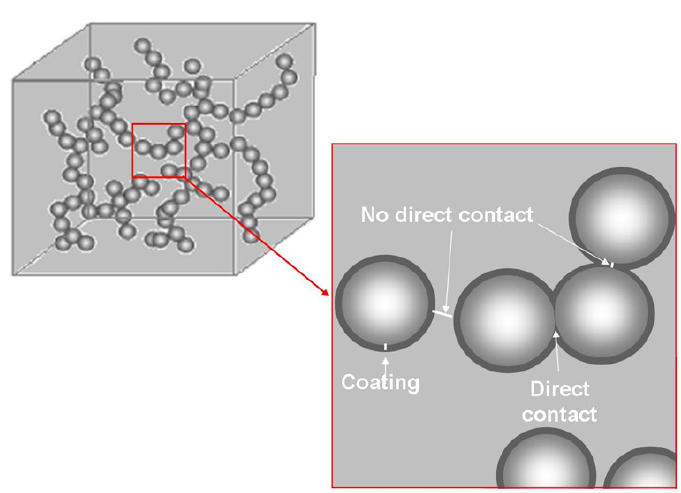
Figure 2. Schematic representation of filler